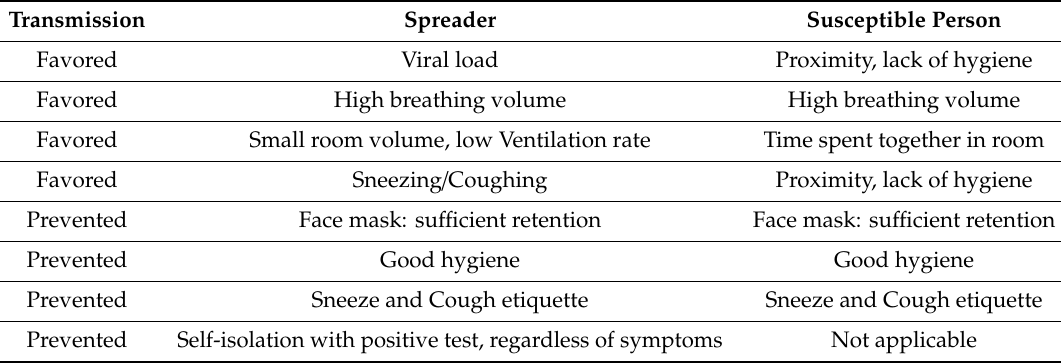
Table 1. Main factors for transmission of